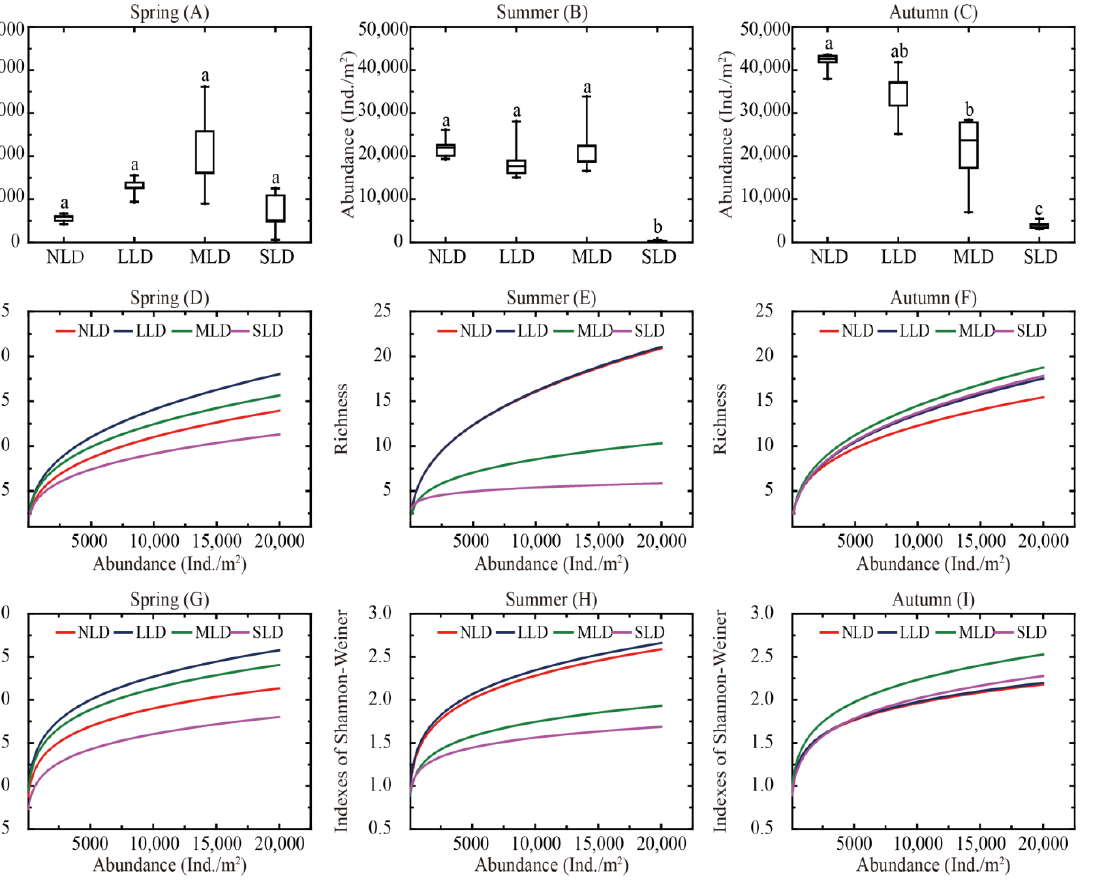
Figure 3. Diversity characteristics of soil Collembolans during the study period. ( A – C ) Box and whisker plots illustrating the medians (line in the box), 25th and 75th percentiles (box), 10th and 90th percentiles (outer lines), and mean values (dots) of abundance ( A ) of soil Collembolans in different land-degradation habitats. ( D – I ) Rarefaction curves of soil Collembolan richness and Shannon–Wiener index assemblage in different land-degradation habitats. Same letter(s) indicate no significantly different between each land-degradation habitats at p < 0.05 by Tukey’s HSD. NLD, no land-degradation habitat; LLD, light land-degradation habitat; MLD, moderate land-degradation habitat; SLD, severe land-degradation